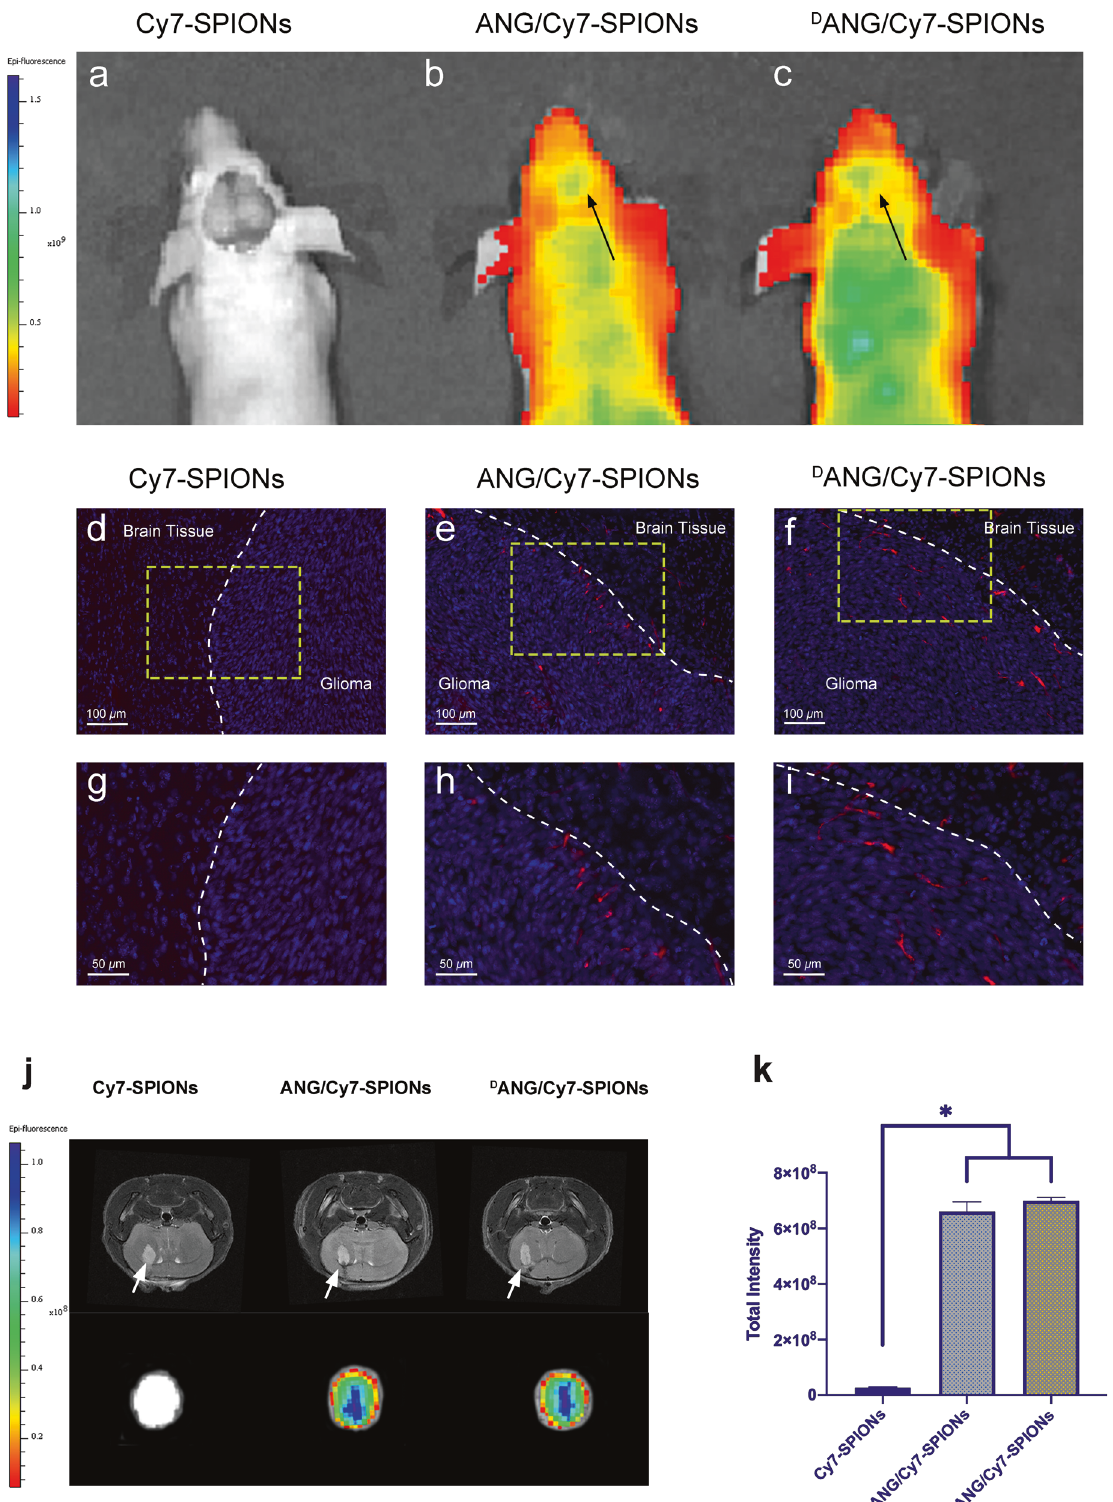
Fig. 8 a In vivo images of tumour-bearing mice injected with Cy7-SPIONs, b ANG/Cy7-SPIONs, and c D ANG/Cy7-SPIONs probes which were conducted with an IVIS imaging system. Images of glioma-containing brain slices from mice injected with d Cy7-SPIONs, e ANG/Cy7-SPIONs, and f D ANG/Cy7-SPIONs which was conducted with an automated quantitative pathology imaging system. g – i The images in the lower showed a ×2 magni fi cation of the areas in the yellow boxes in the images above. The border of the glioma is highlighted by the white dotted line. The DAPI signal in blue indicates cells, and the Cy7 signal in red indicates probes. j Ex vivo NIR fl uorescence images of three probes in tumour-bearing brains after intravenous injection for 24 h. The upper images are MRI images showing tumour size; the lower images are NIR fl uorescence images showing the fl uorescence signal of the probes; k The total intensity of the three probes in tumour-bearing brains. Data from at least three independent experiments are shown as the means ± SEMs, n = 3, * p <